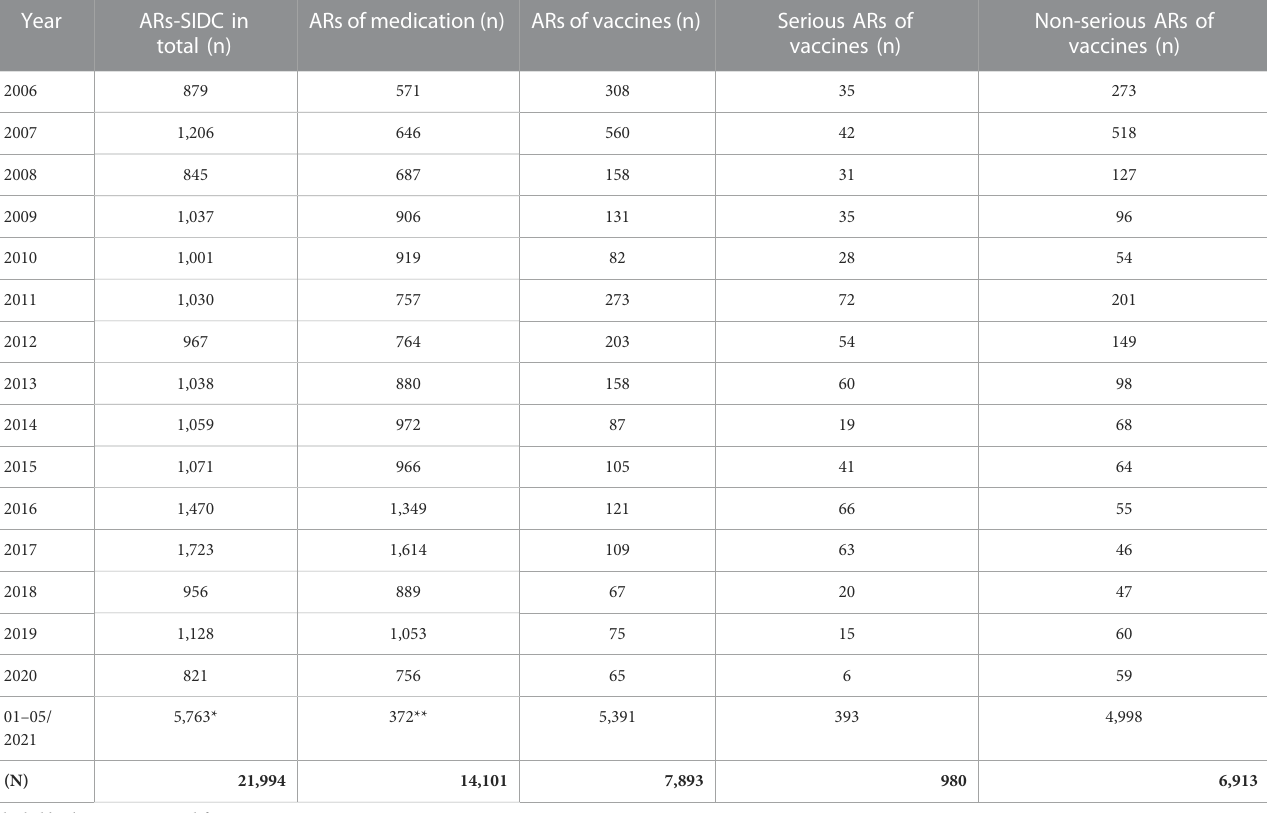
TABLE 1 Numbers of suspected ARs reported to the State Institute for Drug Control during the period from 1 January 2006 to 31 May 2021 in the Slovak Republic. Year ARs-SIDC in ARs of medication (n) total (n)